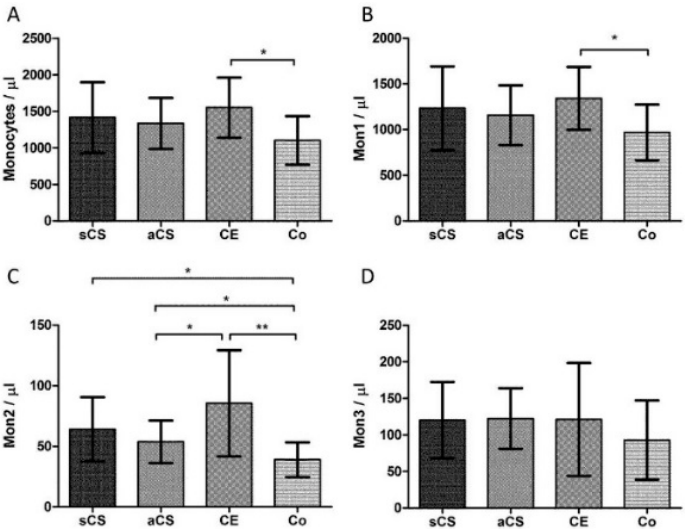
Figure 1. Monocyte subset counts (means ± SD). ( A ) Total monocyte counts; ( B ) counts of classical monocytes (Mon1); ( C ) counts of intermediate monocytes (Mon2); and ( D ) counts of non-classical monocytes (Mon3). aCS: asymptomatic carotid artery stenosis; CE: cardioembolic stroke; Co: controls; sCS: symptomatic carotid artery stenosis. * p <0.05 ** p <0.01.